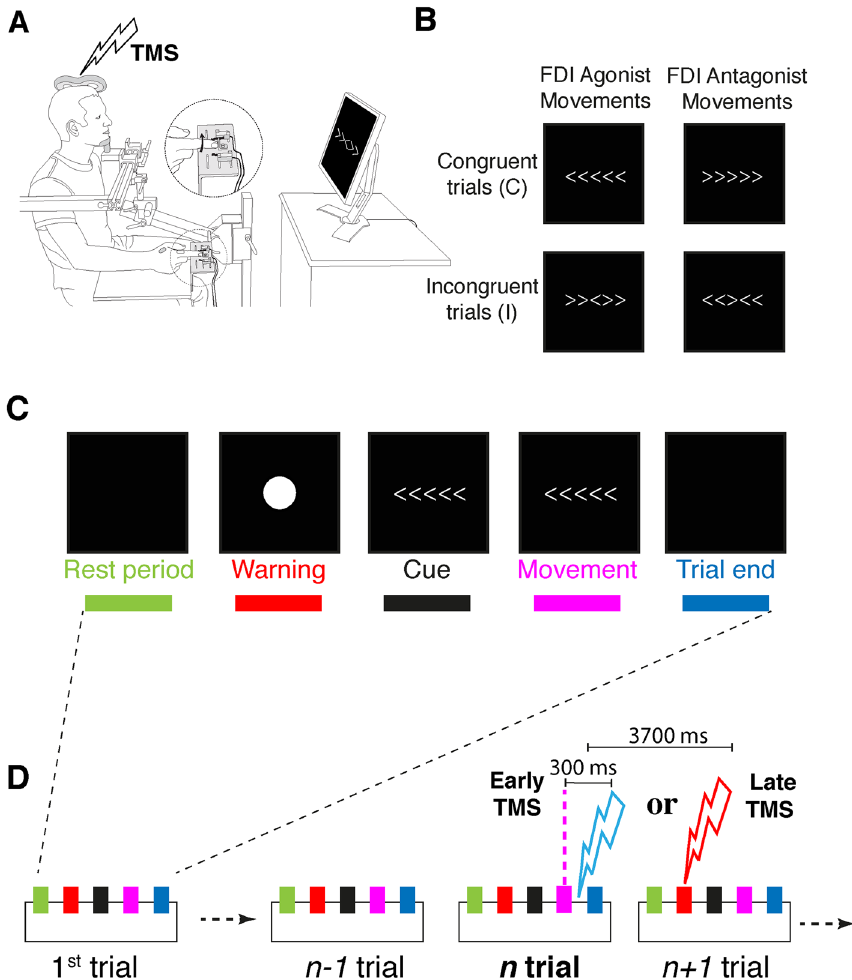
Figure 1. Experimental design. ( A ) Subjects responded to the task by either flexing or extending the index finger of their right hand (inset) in response to the appearance of a visual stimulus. Single-pulse transcranial magnetic stimulation (TMS) was applied over the left primary motor cortex, and EMG activity was recorded from the 1st dorsal interosseus muscle (FDI) of the right hand. ( B ) Experimental conditions of the flanker task involving the 4 possible stimuli. ( C ) Each trial began with a 1000 ms rest period, followed by a 1000 ms warning stimulus (white circle on black screen, 5 cm diameter) displayed at the center of the screen. A 500–800 ms delay then preceded presentation of the cue arrows to which the subject had 2000 ms to respond. The cue arrows were displayed until movement onset and each trial ended approximately 1600 ms after movement completion. ( D ) During the task, single-pulse TMS was applied relative to the movement in the current ( n ) trial at 2 different latencies (early, at 300 ms post-movement and late, at 3700 ms post-movement). Note that, effectively, the late TMS for the current trial fell at the beginning of following ( n + 1) trial. TMS pulses of the two latencies were never applied within the same trial or between two consecutive trials in order to avoid a potential cumulative effect of